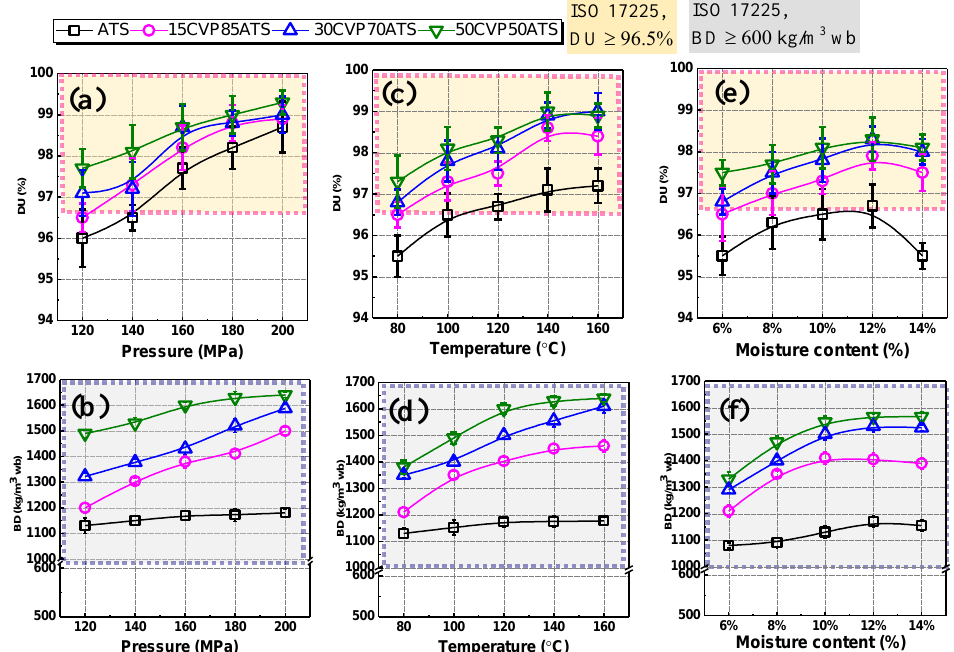
Figure 2. Physical properties of ATS and Chlorella vulgaris and sawdust blends (CSBs; 15CVP85ATS, 30CVP70ATS, and 50CVP50ATS) based on ISO 17225 (common experiment: 140 MPa, 120 °C, 10%): ( a , b ) Relationship between bulk density (BD), mechanical durability (DU), and pressure, ( c , d ) relationship between BD, DU, and temperature, and ( e , f ) relationship between BD, DU, and moisture content.